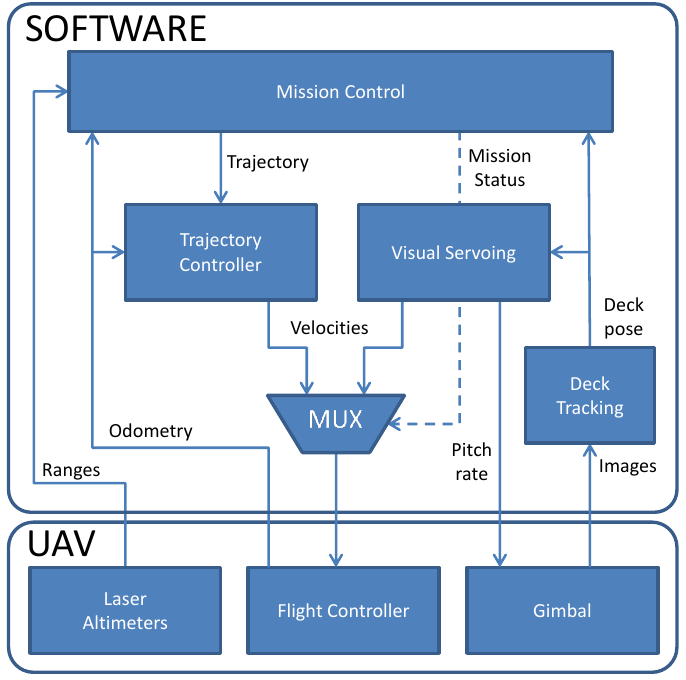
Figure 6. System architecture used in the development of the system.